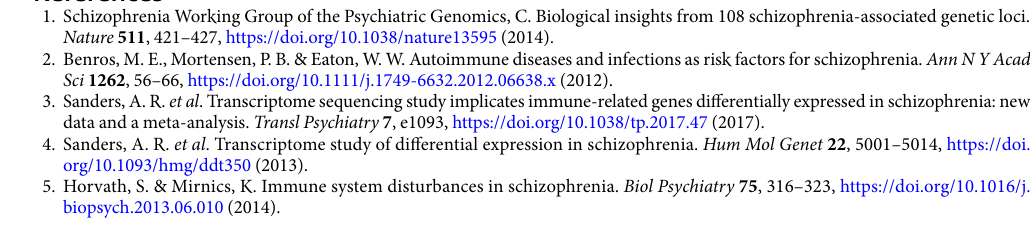
9 SCIEntIFIC RePoRtS | 7: 12586 | DOI:10.1038/s41598-017-12986-0